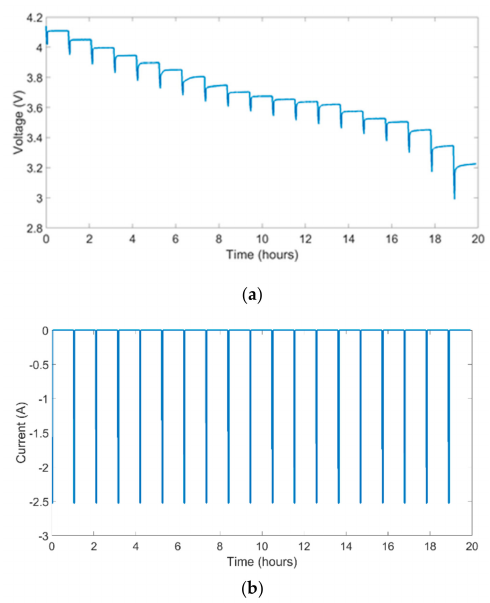
Figure 3. Pulse discharge in 5% increments of the SOC. ( a ) Experimental data of open circuit voltage. ( b ) Experimental data of discharged current.